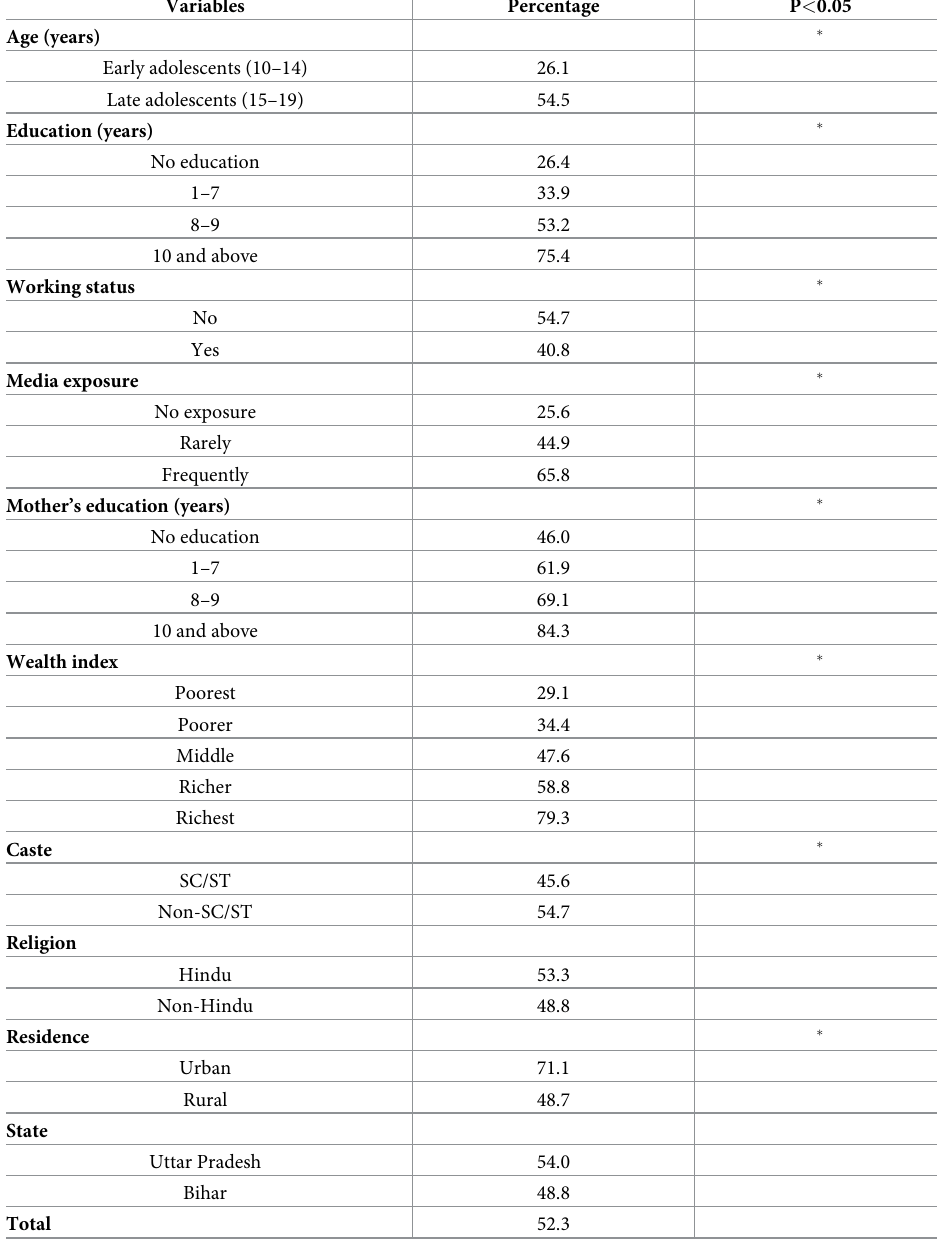
Table 2. Percentage distribution of adolescent girls who use sanitary napkins by background